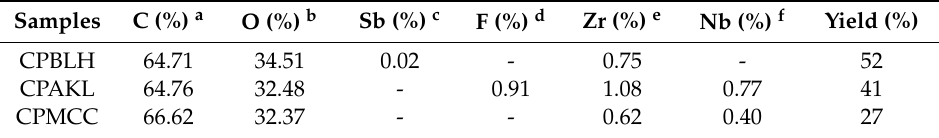
Table 1. Elements composition and yield of fiber